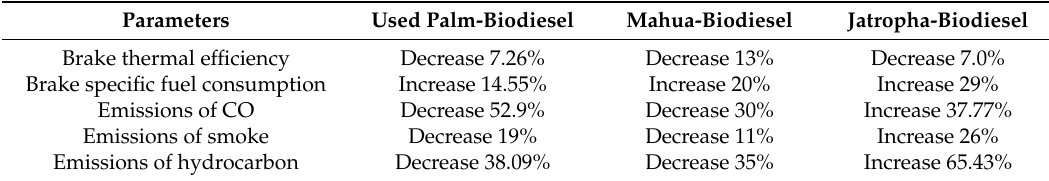
Table 10. Comparison between different types of biodiesels and petro-diesel used for compression ignition engine